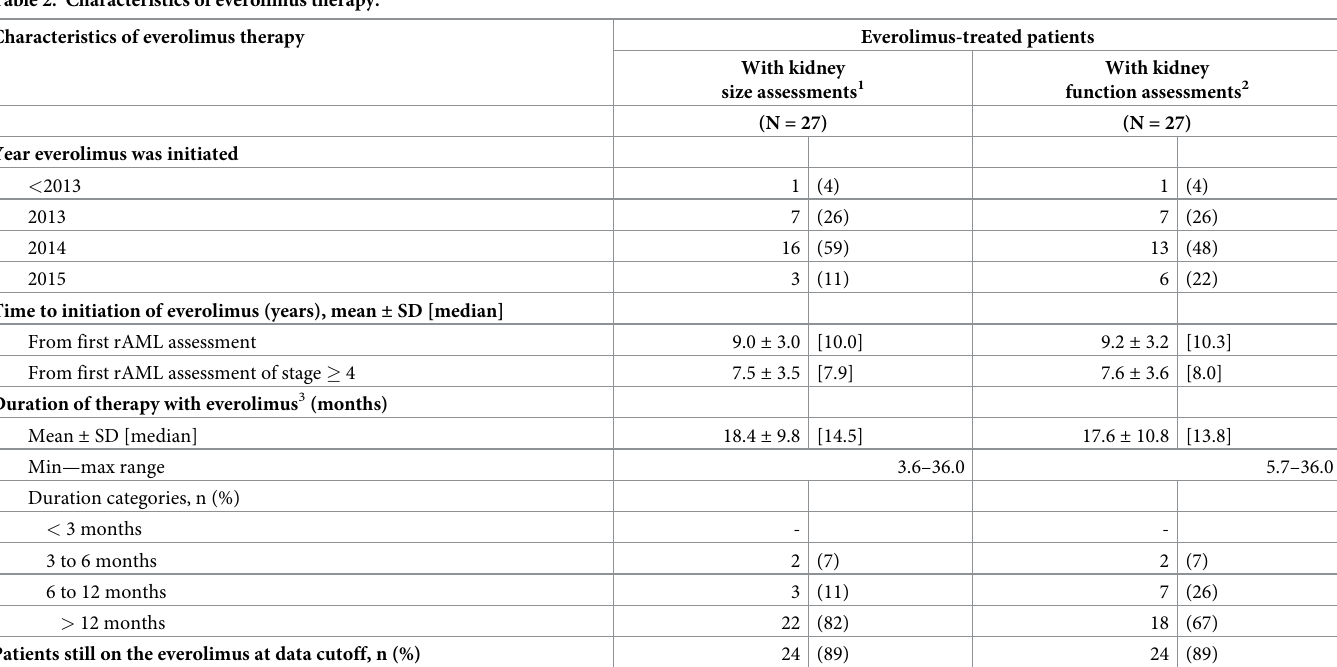
Table 2. Characteristics of everolimus